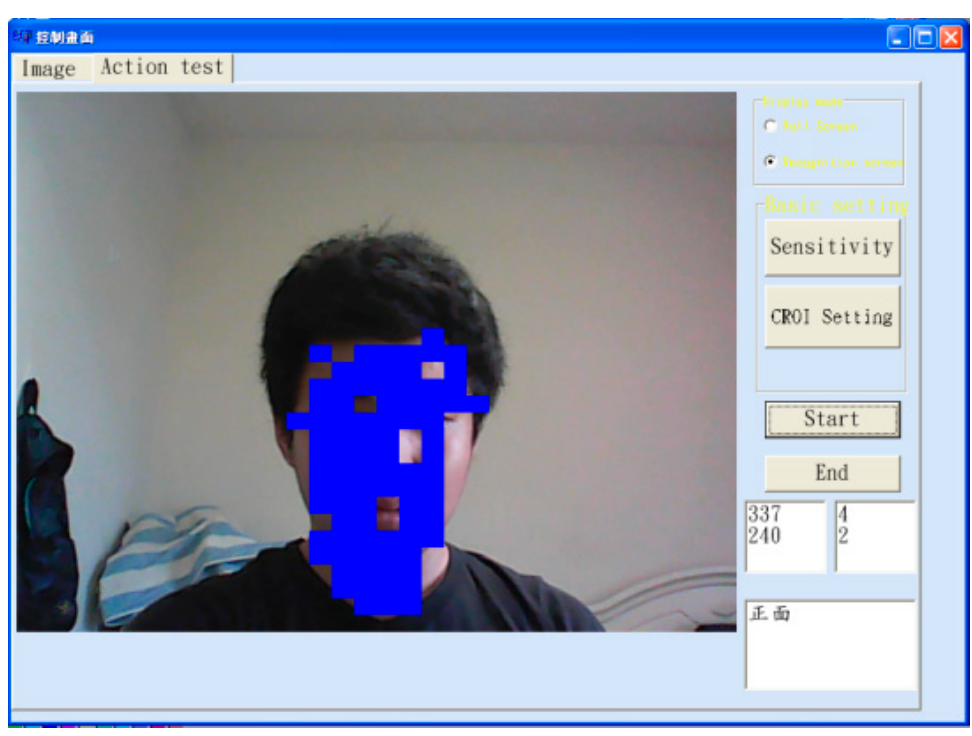
Figure 1. The proper skin color threshold result in the image.